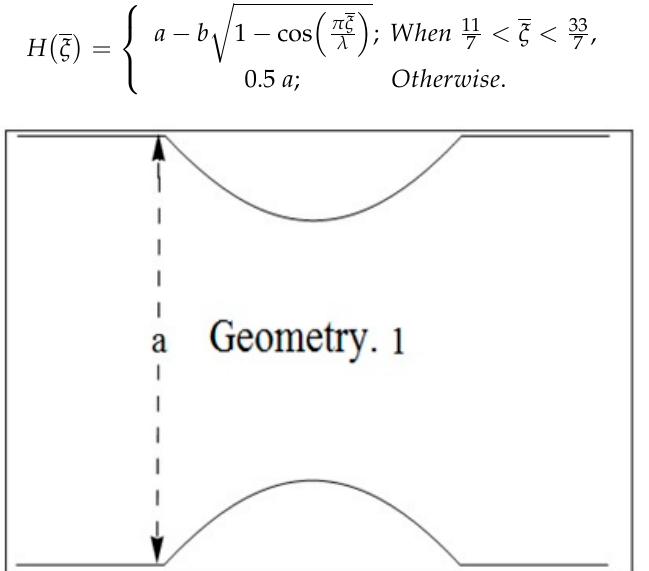
Figure 1. Physical sketch of the geometry.